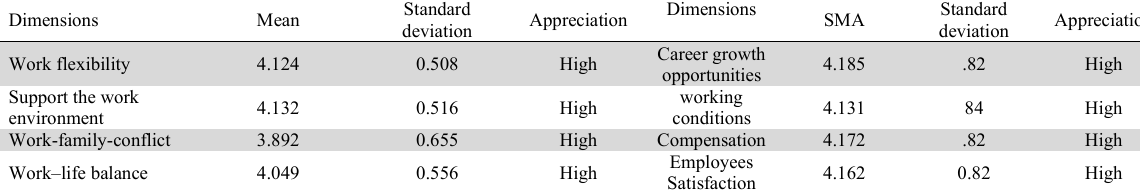
The summary of the data associated with work experience and employee performance Dimensions